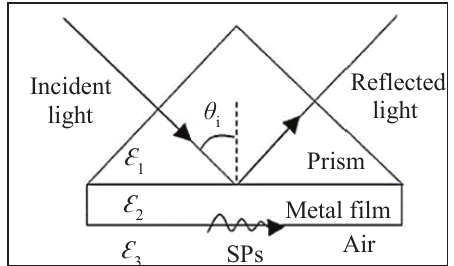
Fig. 1. SPR phenomenon